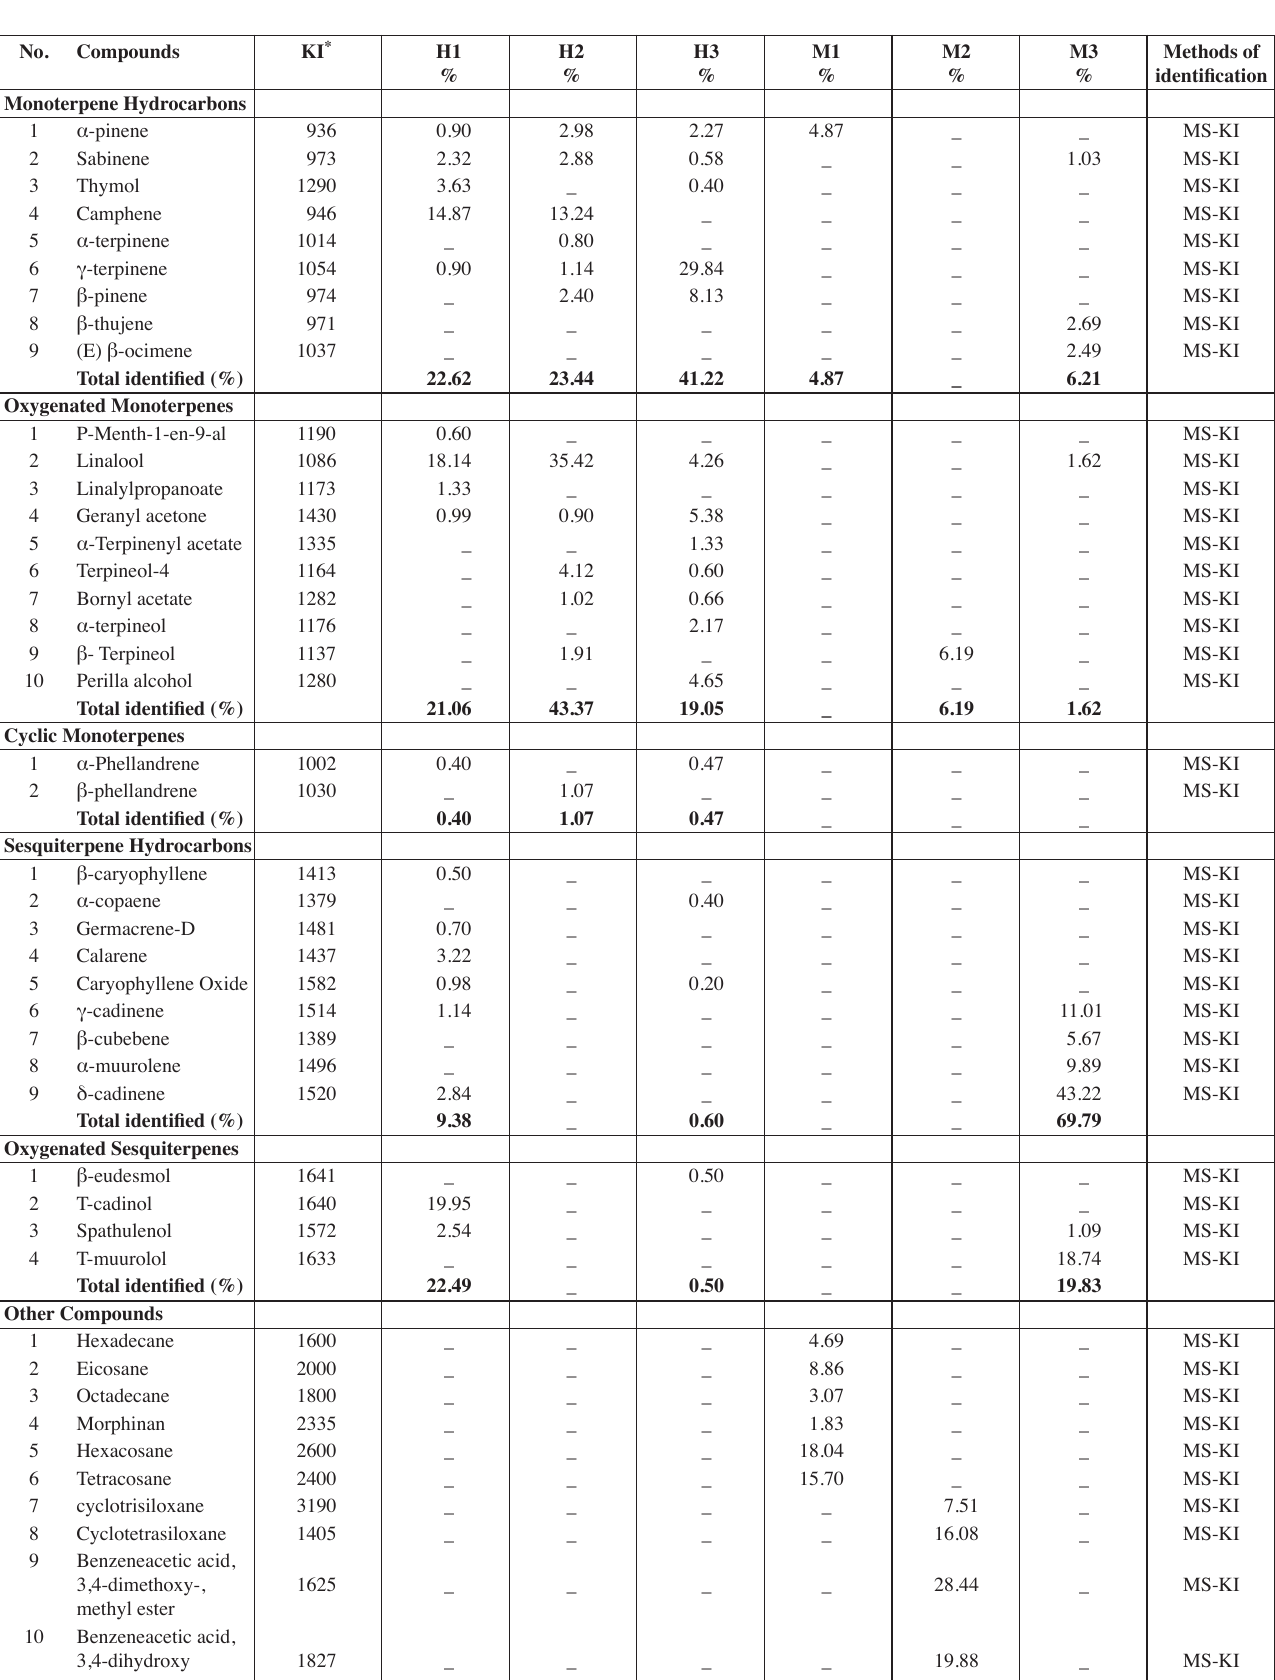
Tab. 6: GC-MS analysis of F. excelsior two phenotypes H and M for pollen grains essential oil compounds during three periods of